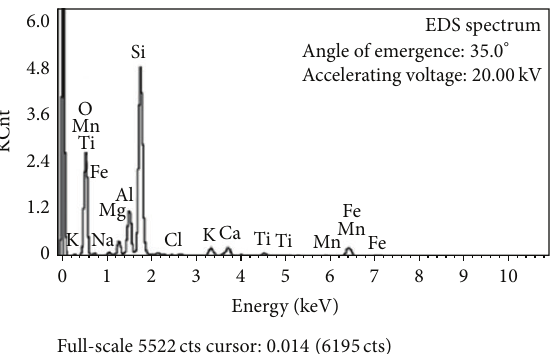
Figure 3: EDS analysis results of adobe sample.